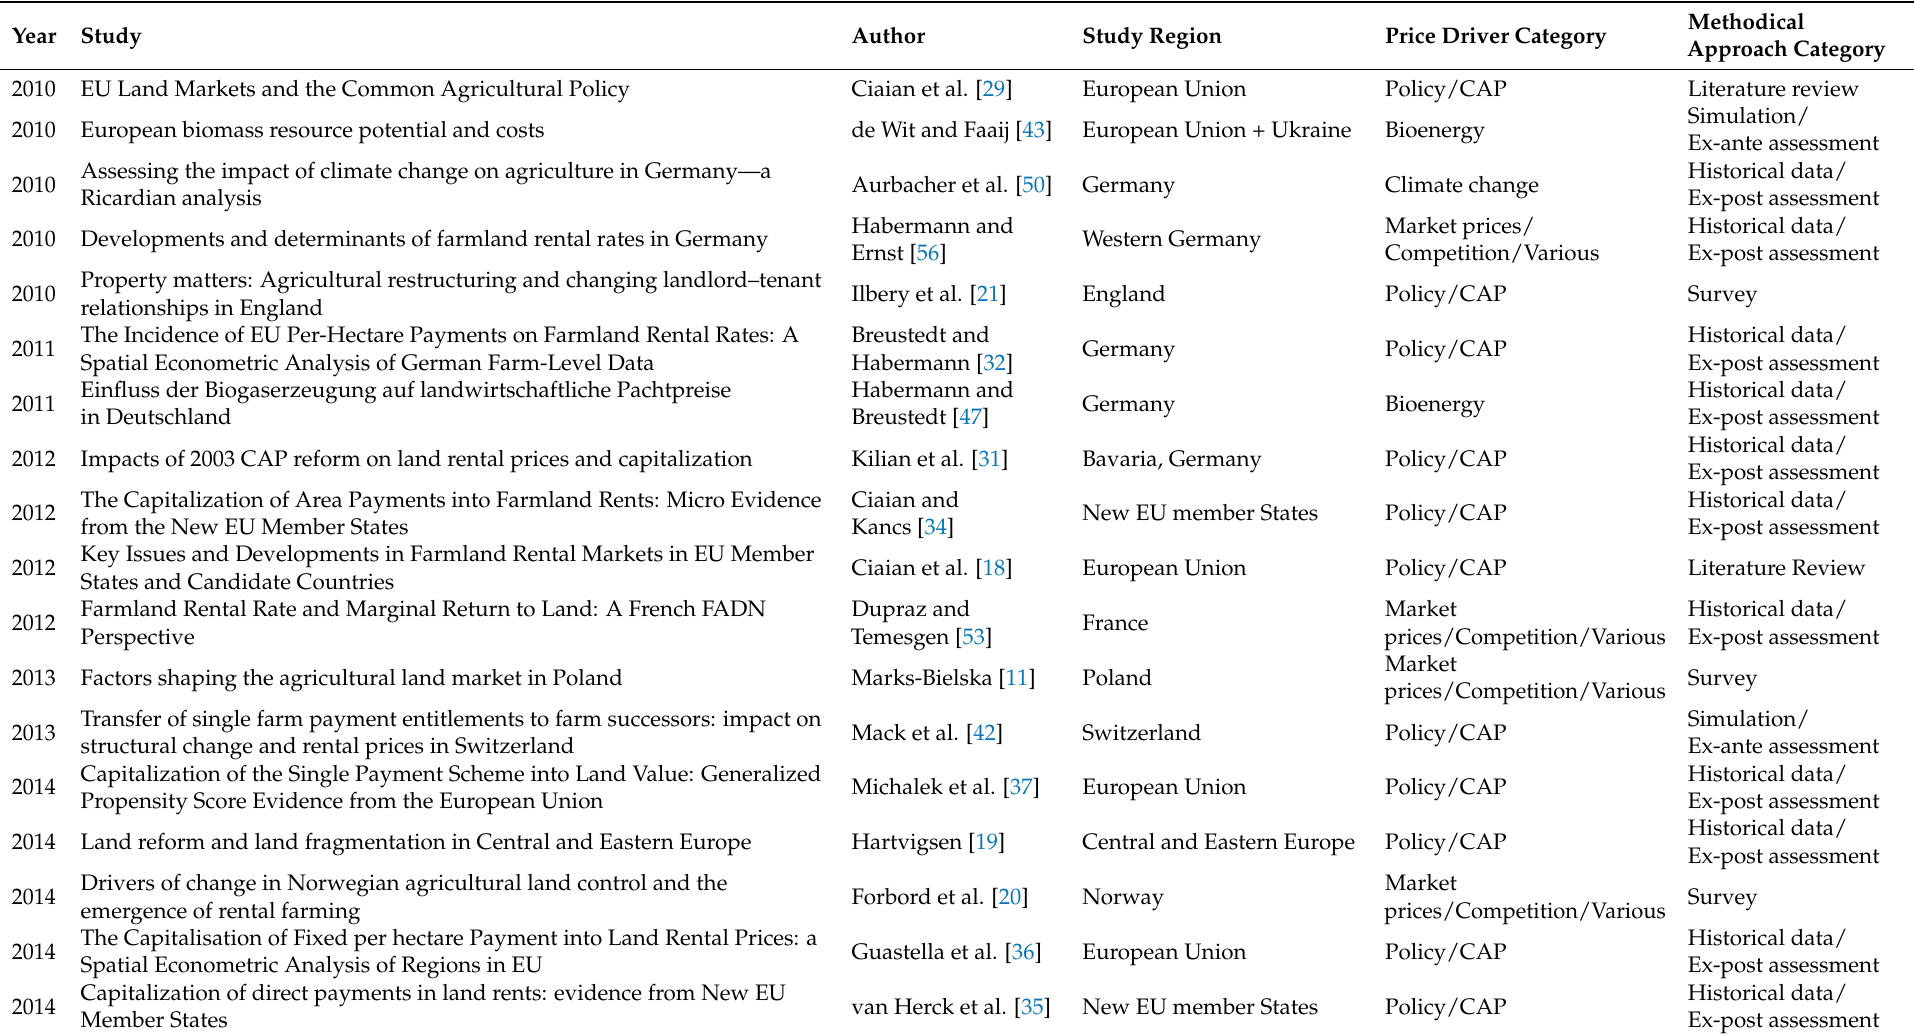
Table 2. Studies analyzed within the framework of the systematic literature